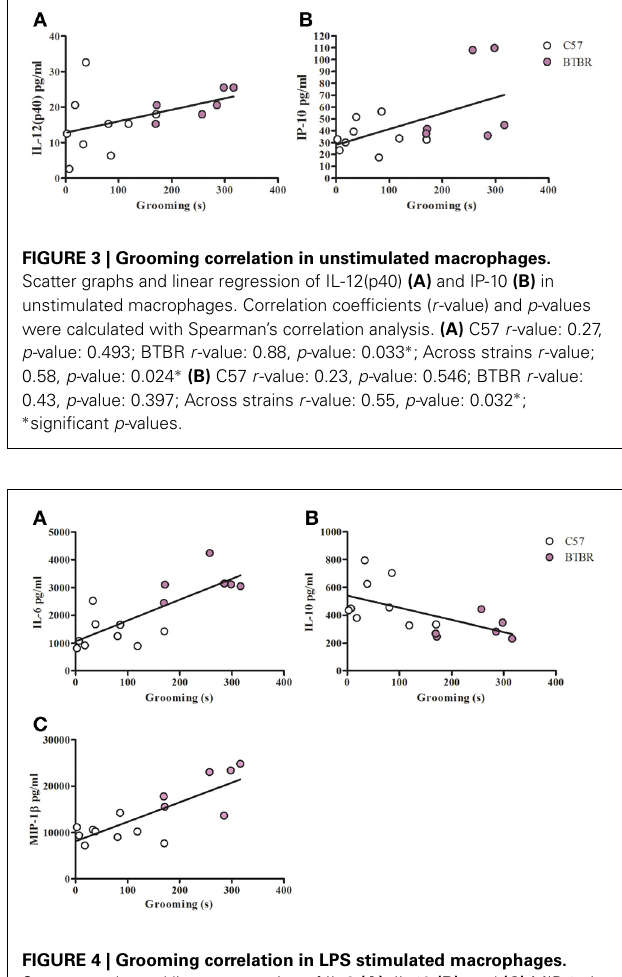
FIGURE 4 | Grooming correlation in LPS stimulated macrophages. Scatter graphs and linear regression of IL-6 (A) , IL-10 (B) , and (C) MIP-1 β in LPS stimulated macrophages. Correlation coefficients ( r -values) and p- values were calculated with Spearman’s correlation analysis. (A) C57 r -value: 0.30, p- value: 0.433; BTBR r -value: 0.20, p- value: 0.704; Across strains r -value: 0.77, p- value: 0.001 ∗ (B) C57 r -value: − 0 . 22, p- value: 0.576; BTBR r -value: − 0 . 09, p- value: 0.872; Across strains r -value: − 0 . 63, p- value: 0.012 ∗ (C) C57 r -value: − 0 . 15, p- value: 0.708; BTBR r -value: 0.60, p- value: 0.241; Across strains r- value: 0.67, p- value: 0.006; *significant p- values.